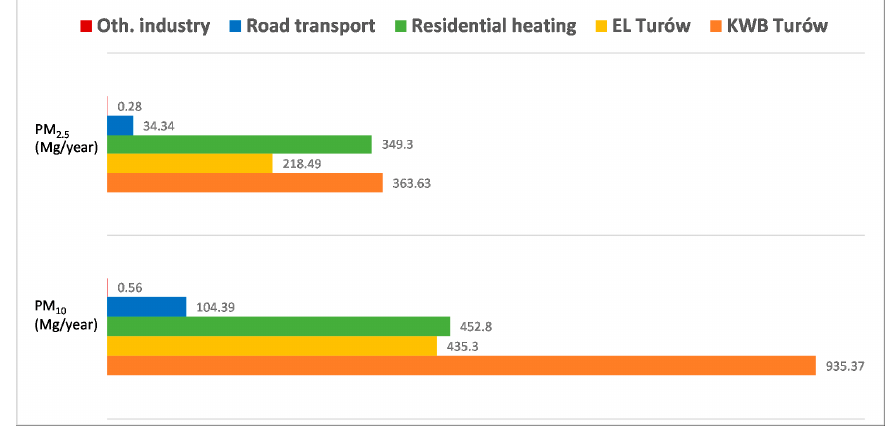
Figure 4. Particulate matter emissions for different emission sources inventoried in Bogatynia commune (source: own study) .